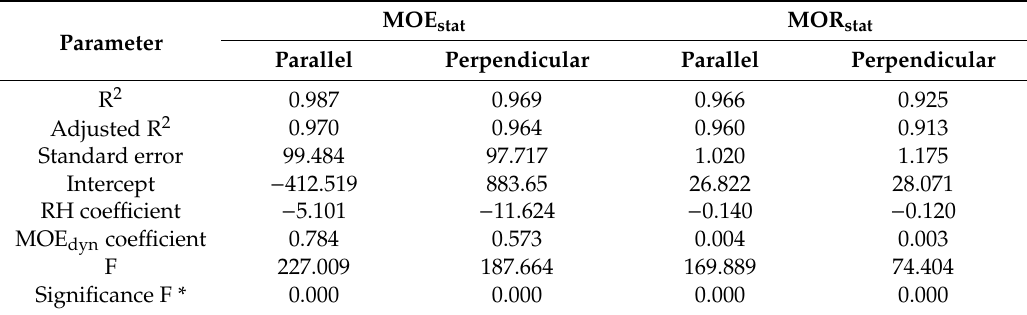
Table 5. Model summary of regression statistics for MOE stat and MOR stat prediction. Parameter